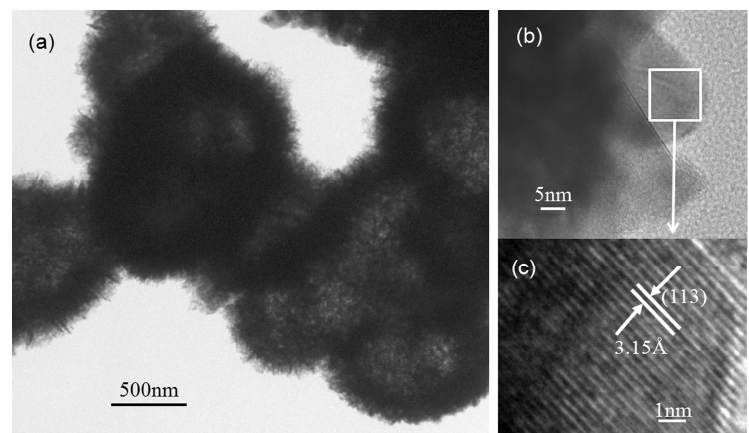
Figure 2. ( a ) General and ( b ) higher magnification transmission electron microscope (TEM) image of hierarchical Bi 2 WO 6 hollow spheres; and ( c ) enlarged high ‐ resolution transmission electron microscopy (HRTEM) image taken on a white rectangle marked part in Figure 2b. The hierarchical Bi 2 WO 6 hollow spheres were synthesized at 160 °C for 12 h.